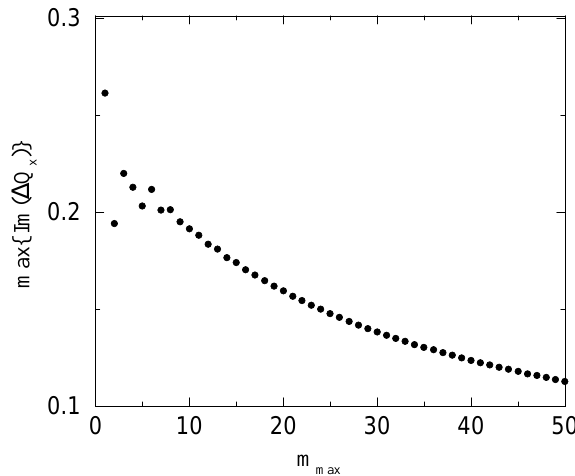
FIG. 4. Largest value of Im (cid:115) D (cid:81) (cid:120) (cid:100) versus (cid:109) max for (cid:81) (cid:115) (cid:173) (cid:48) . to the transverse size of the charge distribution, the trans- verse force varies almost linearly with displacement. If the initial transverse offsets are small compared to